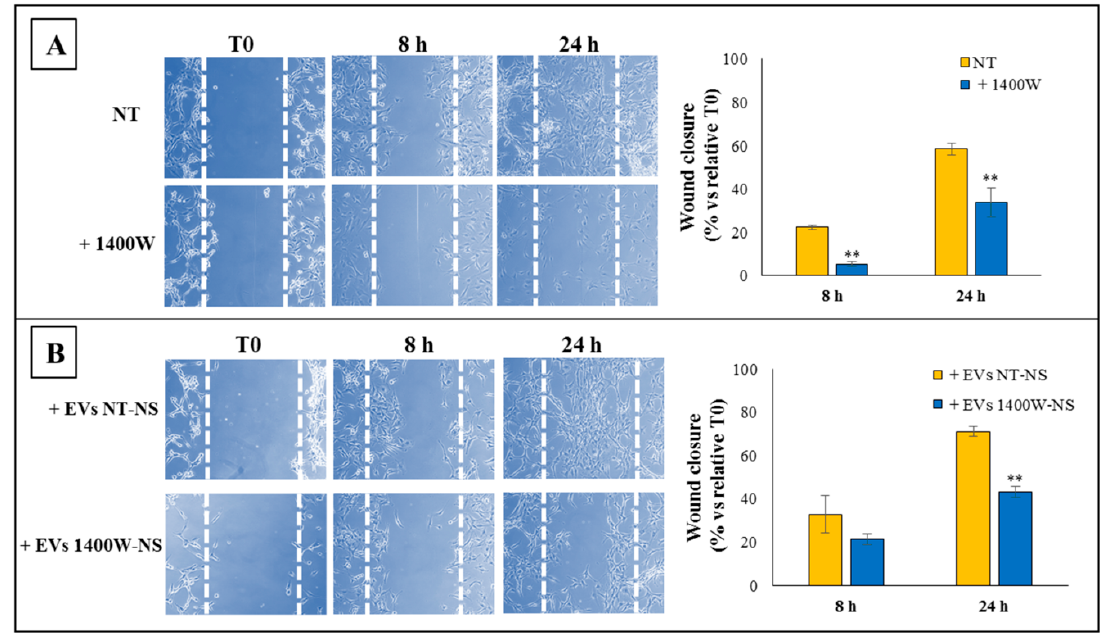
Figure 7. Cell migration ability of adherent U87MG cells treated with 1400W or EVs released by NT-NS or 1400W-treated NS. ( A ) Scratched monolayers of adherent U87MG cells were incubated up to 48 h without (NT) or with 1400W (100 µ M) to quantify cell motility by measuring the wound width.